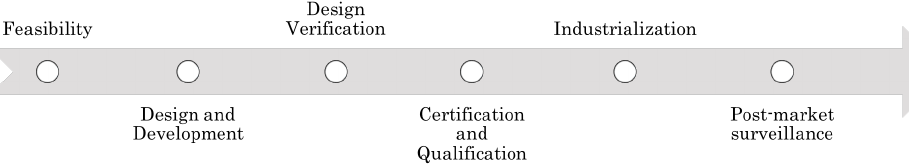
Figure 2. The phases of a medical product design and development strategy.